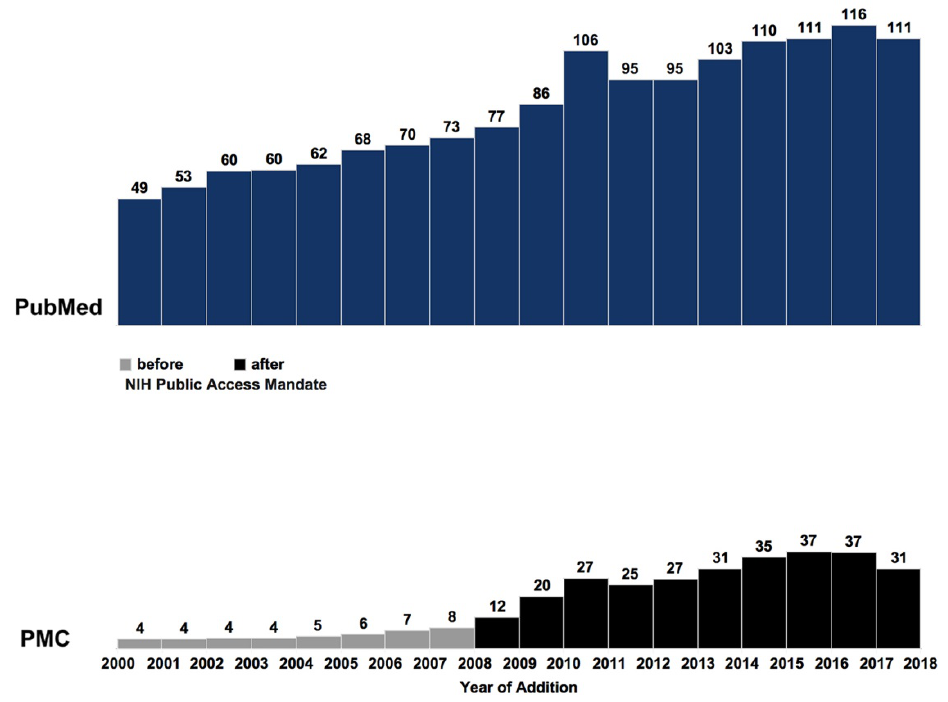
Figure 4 New PubMed and PMC records added by year (by